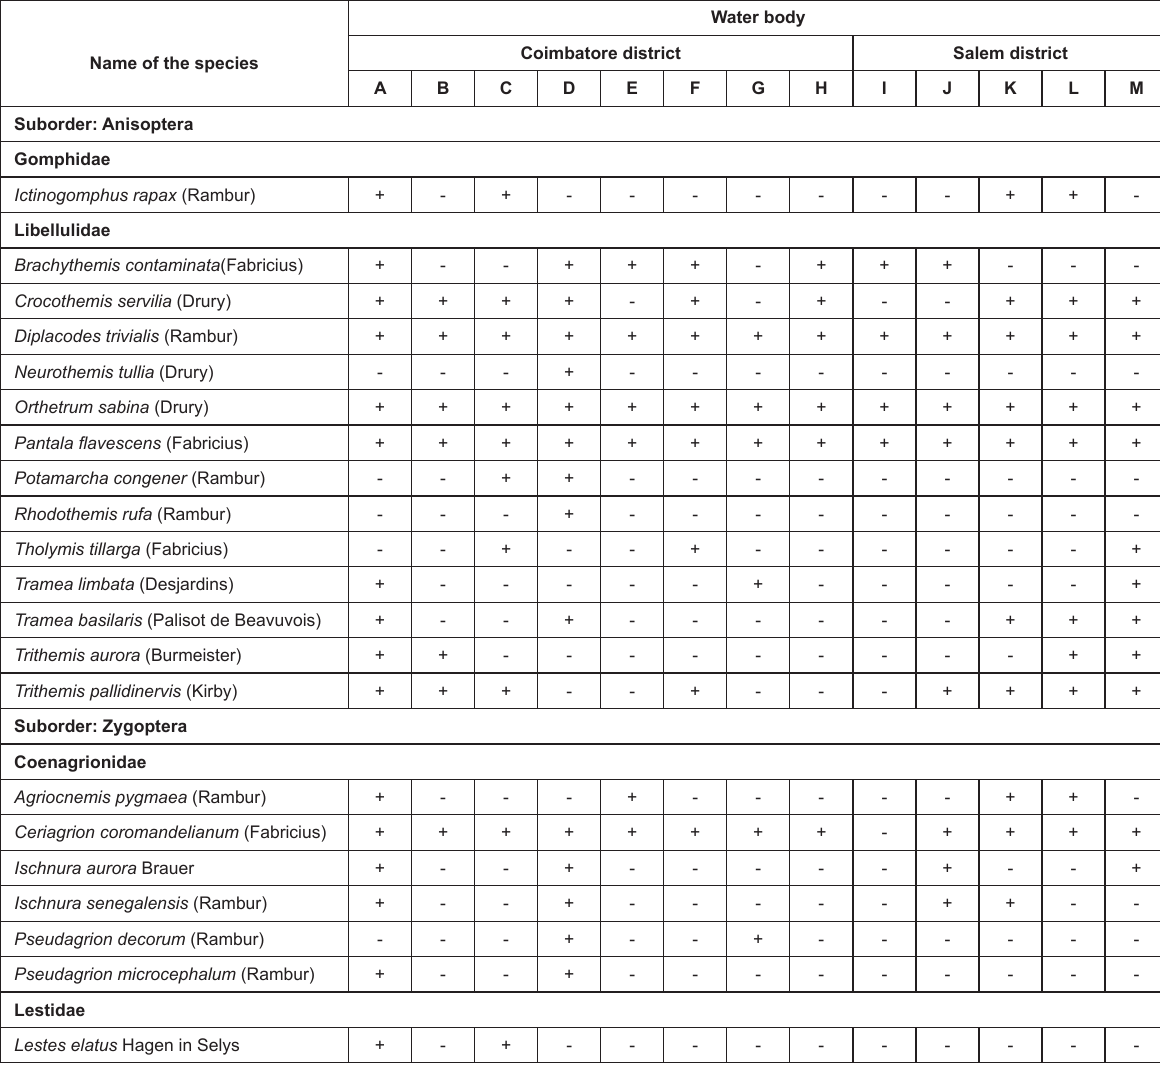
Table 2 Distribution of Odonata in temporary water bodies of Coimbatore and Salem districts of Tamil